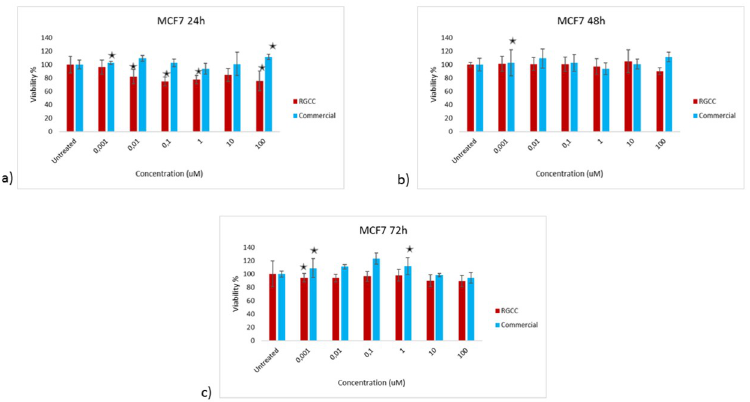
Fig 1. Viability of MCF7 cells after the treatment with various concentrations of genistein R.G.C.C. and genistein commercial. MTT results at a) 24 h, b) 48 h and c) 72 h. The � represents the statistically significant results P -value <